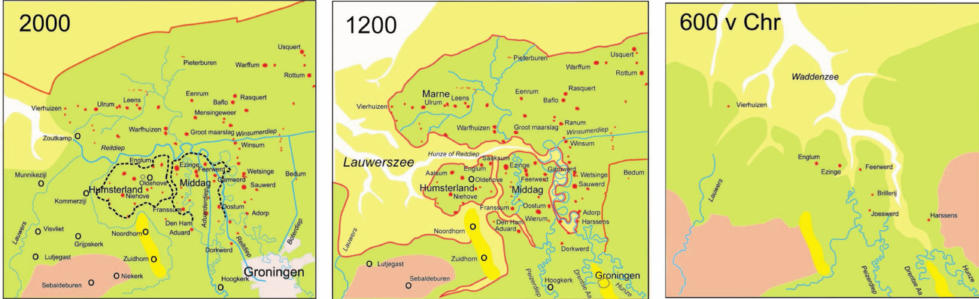
Figure 7. Crucial transformative steps in landscape genesis of the northern Groningen landscape. The transformation from a natural dynamic equilibrium towards the current static situation is illustrated by the sequence of landscape transitions over time (Figure 8). The higher grounds in dark green and the peat in brown are dominant in the early stages, while the influence of saltwater (in red) creates the salt marshes (light green). Over time, the deposition of clay increases (dark green), and this reduces the intrusion of the seawater. After humans start to control and embank the land, agricultural activities emerge, as does urbanization. By the year 2000, a separation of land-based activities and the sea has become a divide.